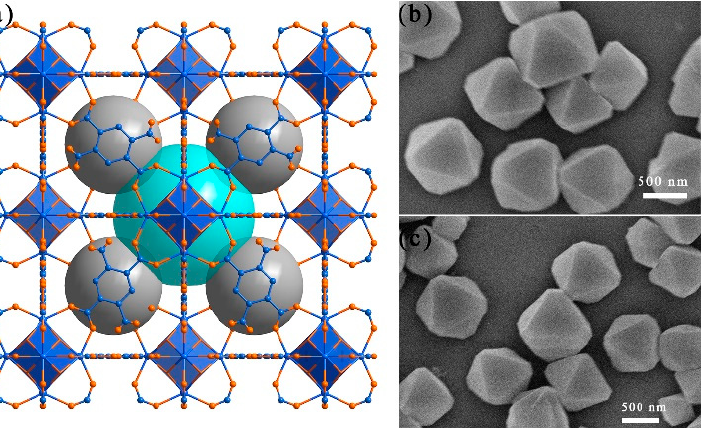
Figure 1. ( a ) Schematic illustration of the structure of UiO-66-(COOH) 2 . SEM morphology of ( b ) as- synthesized UiO-66-(COOH) 2 and ( c ) Ag + @UiO-66-(COOH) 2 .